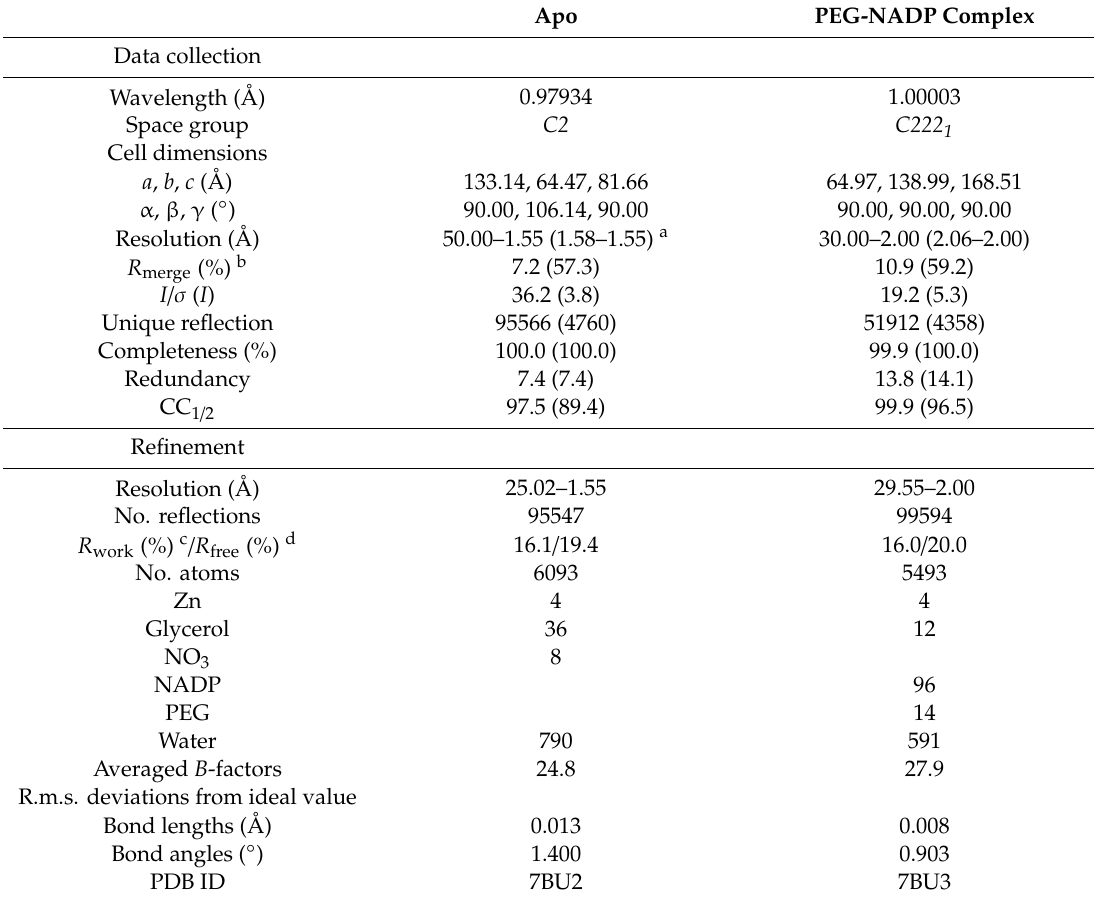
Table 1. Data collection, phasing, and refinement statistics for YjgB from E. coli